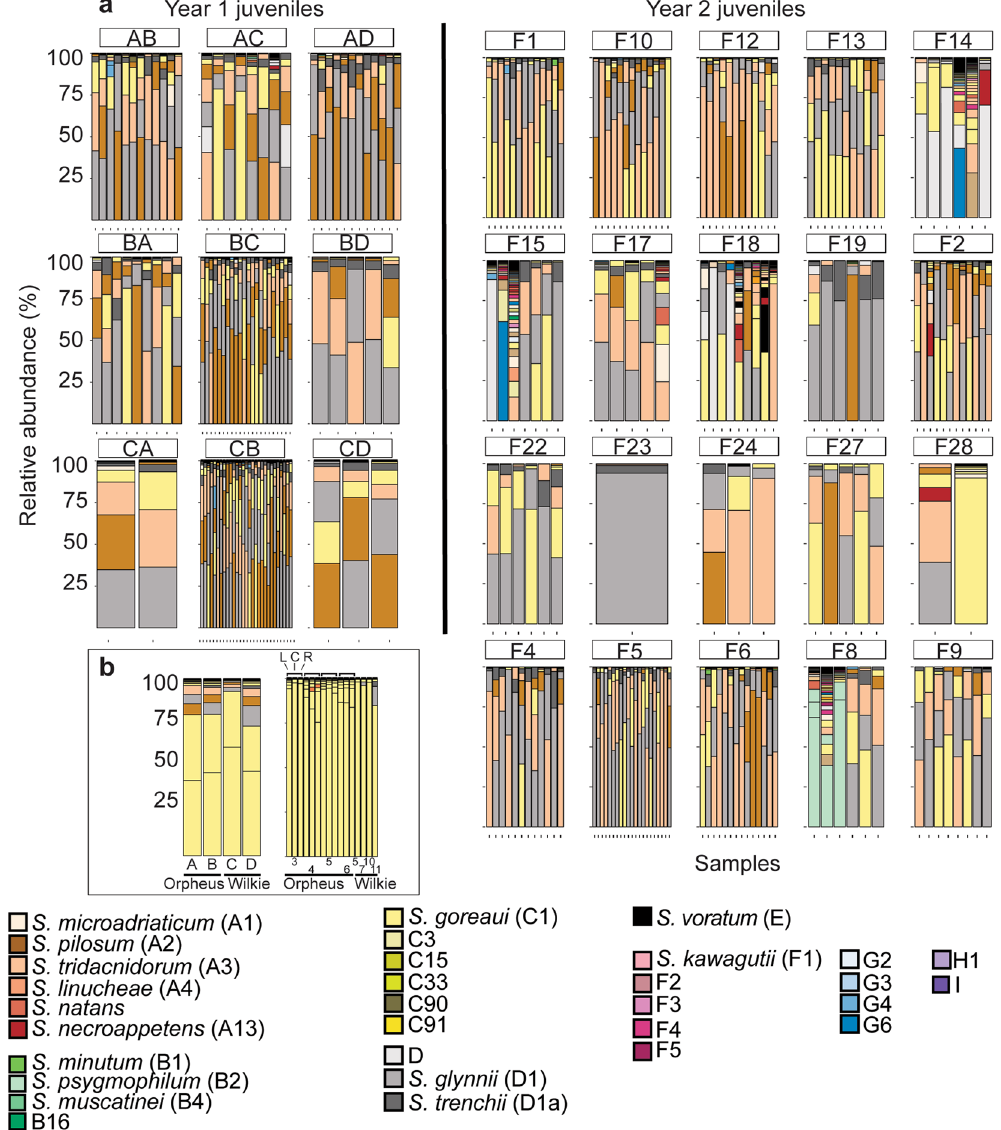
Figure 2. Barplots of variance-normalized abundances of Symbiodinium diversity associated with ( a ) juveniles and ( b ) adults of Acropora tenuis used in 2012 (Year 1) and 2013 (Year 2) crosses. Colours represent different Symbiodinium types. Origins of parent colonies are Orpheus and Wilkie reefs. A . tenuis adult colonies from Orpheus used for 2013 crosses included samples that were sequenced that represent the left side of the colony (L), center of the colony (C), and right side of the colony (R) to examine intra-colony Symbiodinium